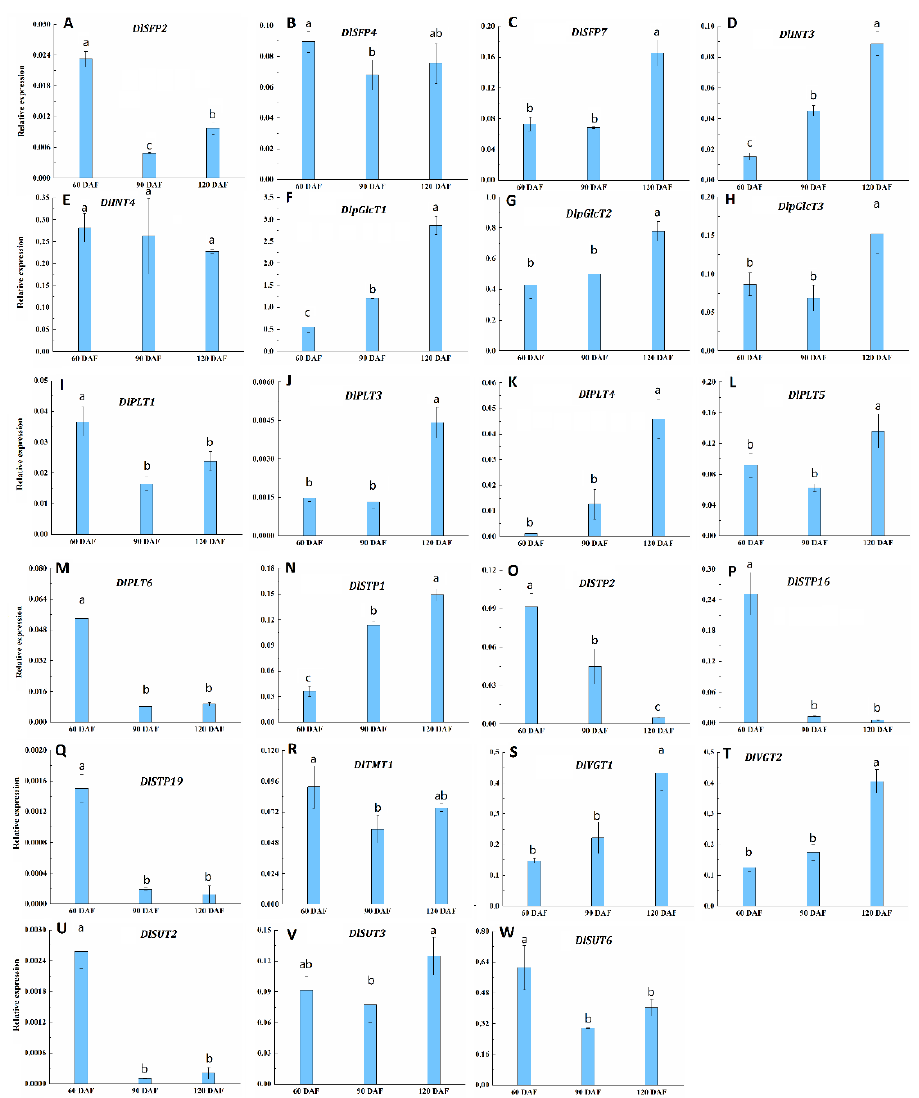
Figure 10. Expression profiles of 23 DlST genes during longan fruit development. Values were mean ± standard error (SE) ( n = 3). Lowercase letter(s) above the bars indicate significant differences ( P - value = 0.05, LSD) among different developmental stages.